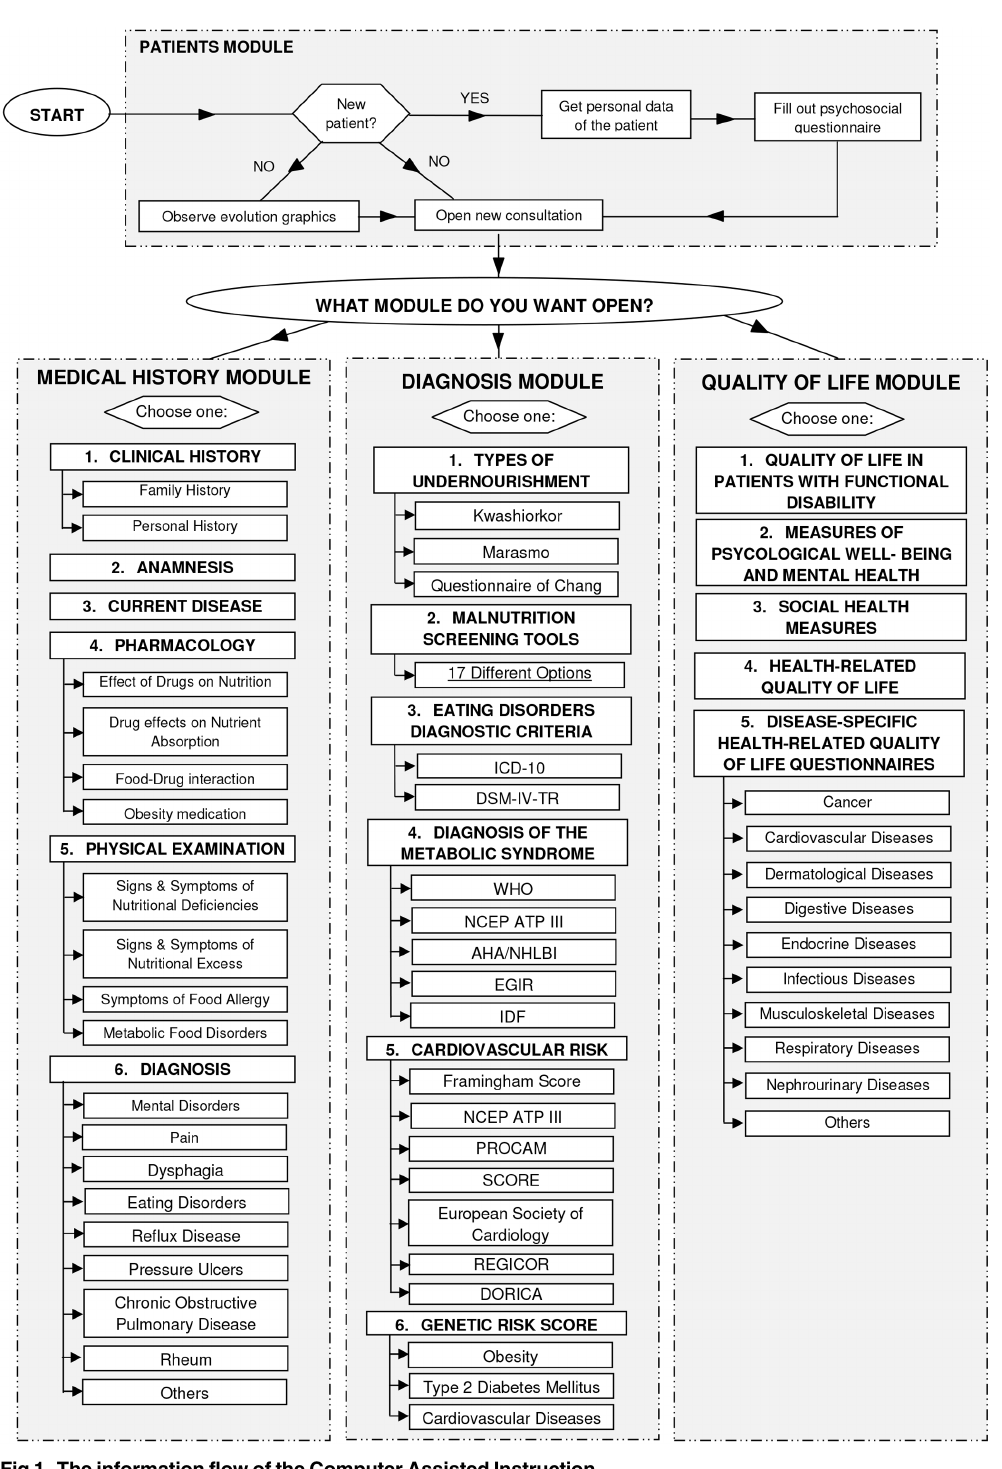
PLOS ONE | DOI:10.1371/journal.pone.0126345 May 15,